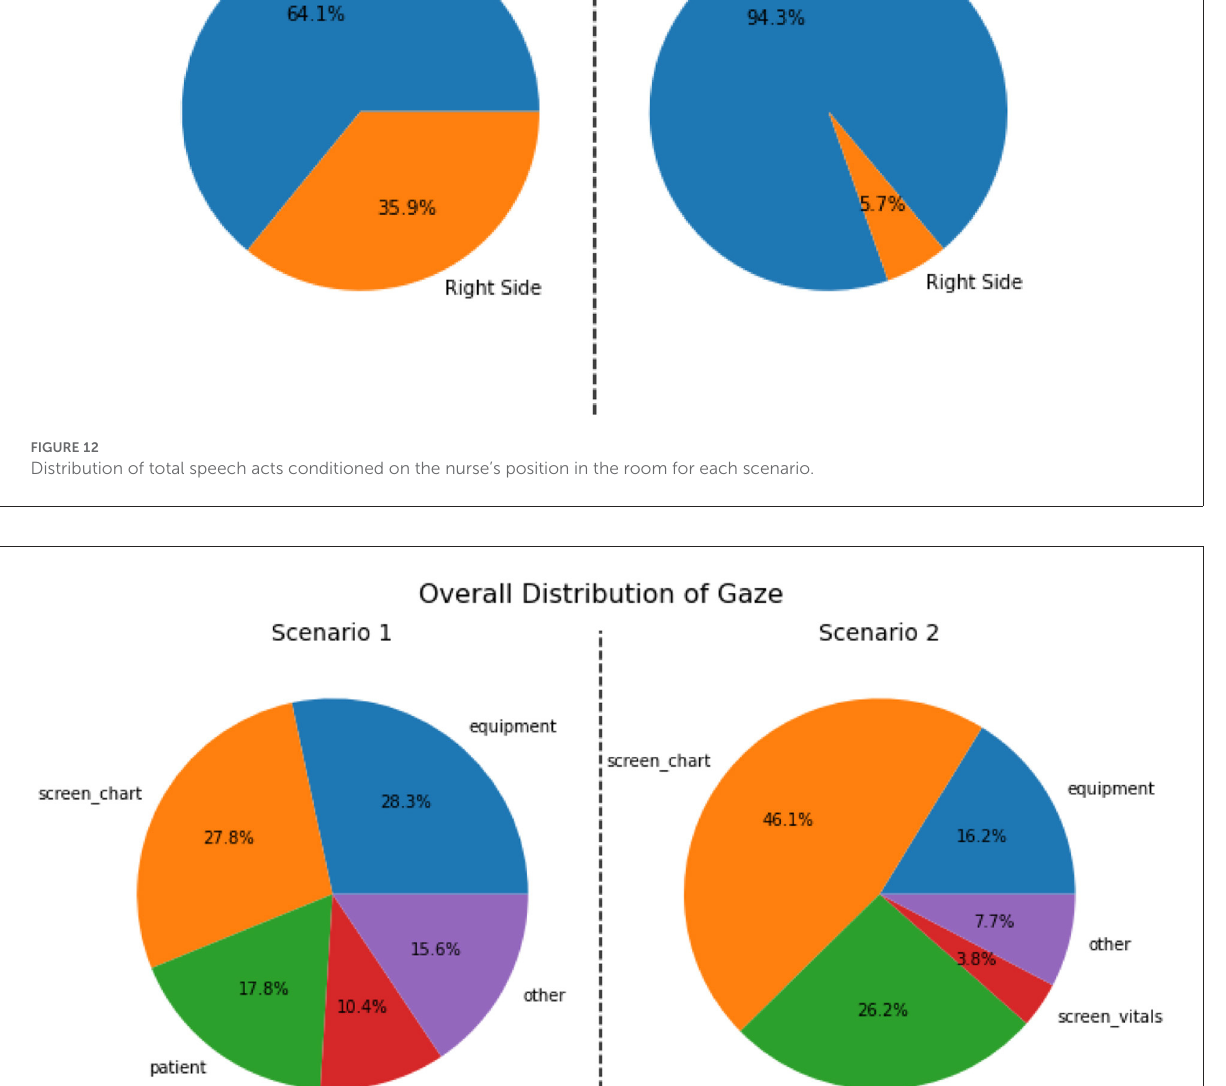
further confirmed the role of each of these spaces in the room; the left side of the bed was primarily used for information gathering and the right side was primarily used for providing clinical